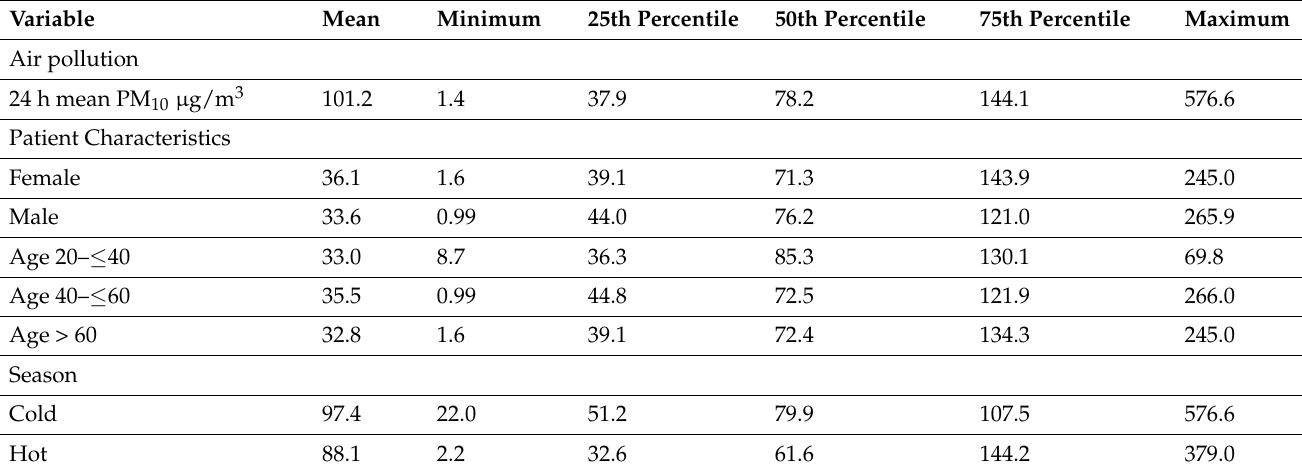
Table 3. Air pollution statistics for PM 10 in relation to patient demographic and season characteristics.